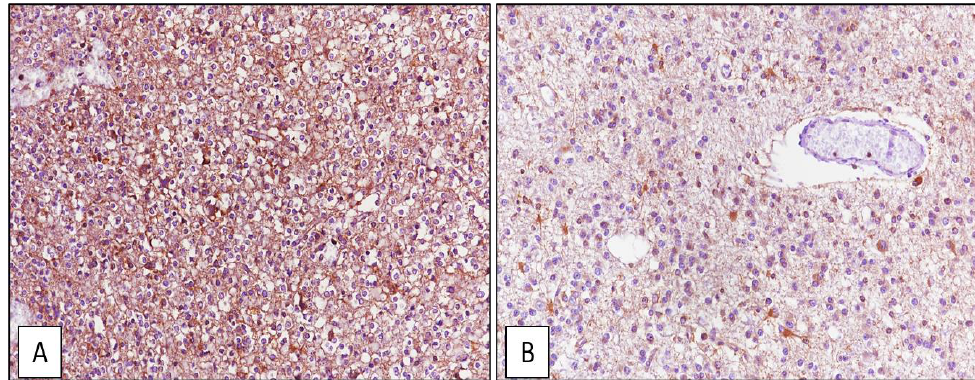
Figure 9. GBM tissue sample. High ( A ) and low ( B ) immunohistochemical expression of ATG7; high ( C ) and low ( D ) immunohistochemical expression of ATG4 (immunoperoxidase staining; original magnifications 200×).